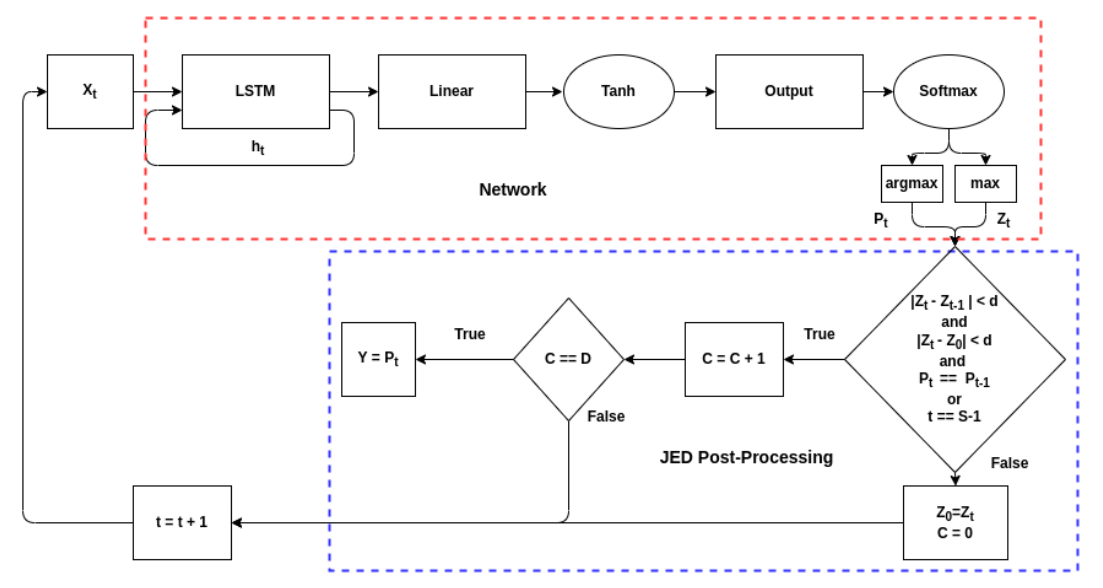
Figure 10. A diagram of the JED process where d is delta-threshold , D is duration , and S is the maximum number of samples that can be